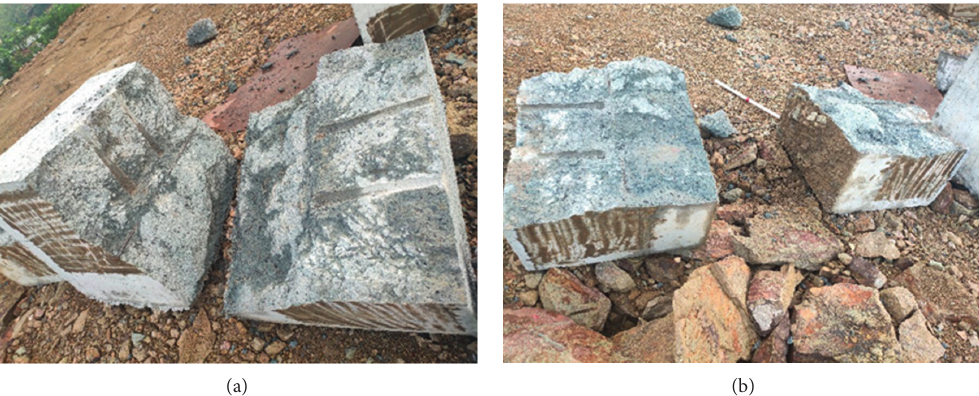
Figure 8: Damage and crack propagation of dual-hole blasting: (a) conventional blasting; (b) multidirectional shaped charge